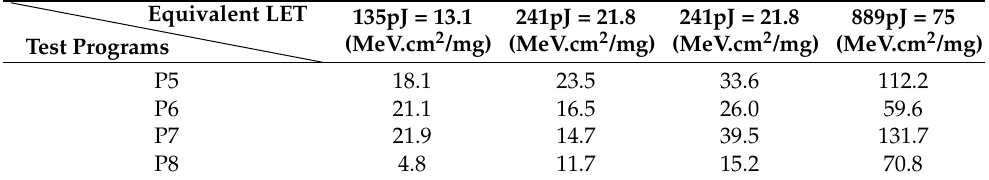
Table 3. Laser SEE soft error cross section of validation set (10 − 7 errors/cm 2